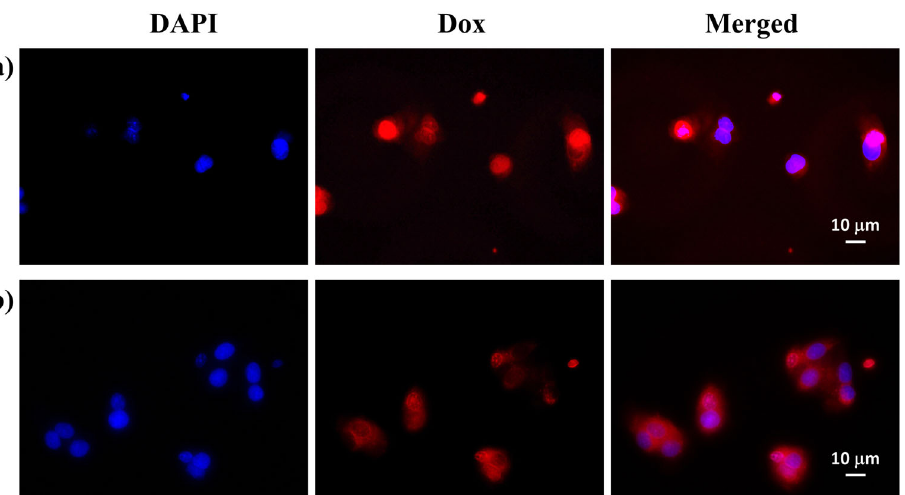
Figure 9. Florescence microscopy images of HepG2 cancer cells treated with Dox@FCPDA nanopar- ticles ( a ) 3 h and ( b ) 6 h incubation (blue color indicates the cells stained with DAPI and red color indicates Dox).